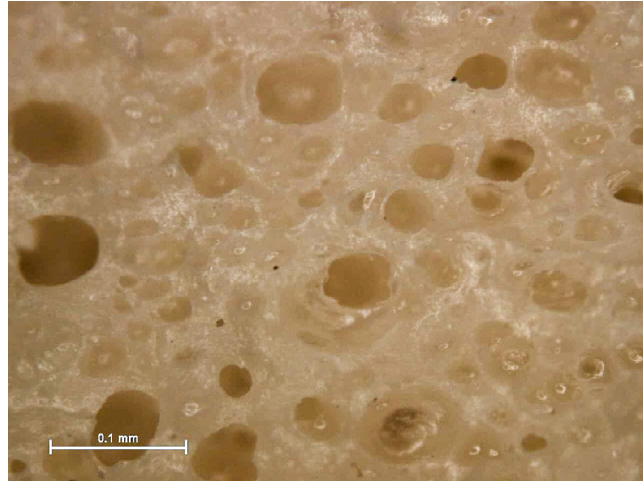
Figure 9. Microstructure of the porous natural rubber foam. Density is one of the most critical parameters of insulating foam because it impacts foam performance for many applications, such as strength, modulus, and thermal